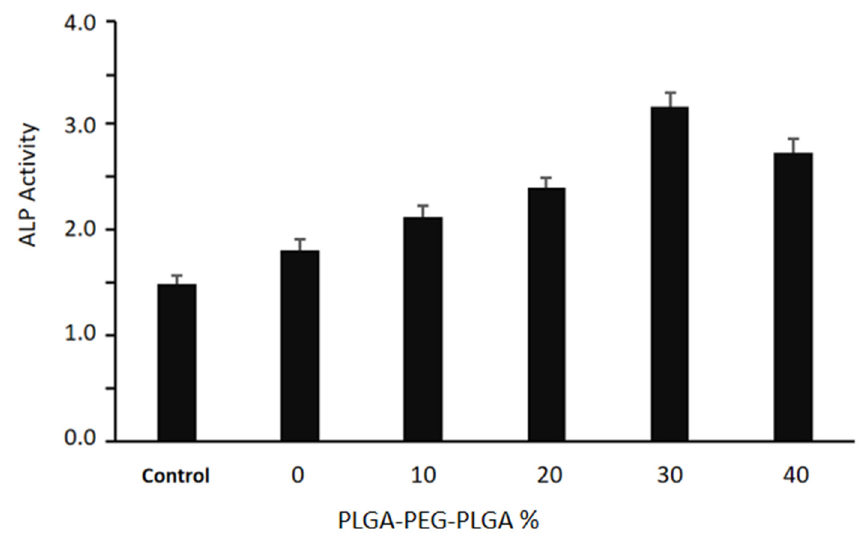
Figure 13. Quantitative results of ALP activity test after 14-day